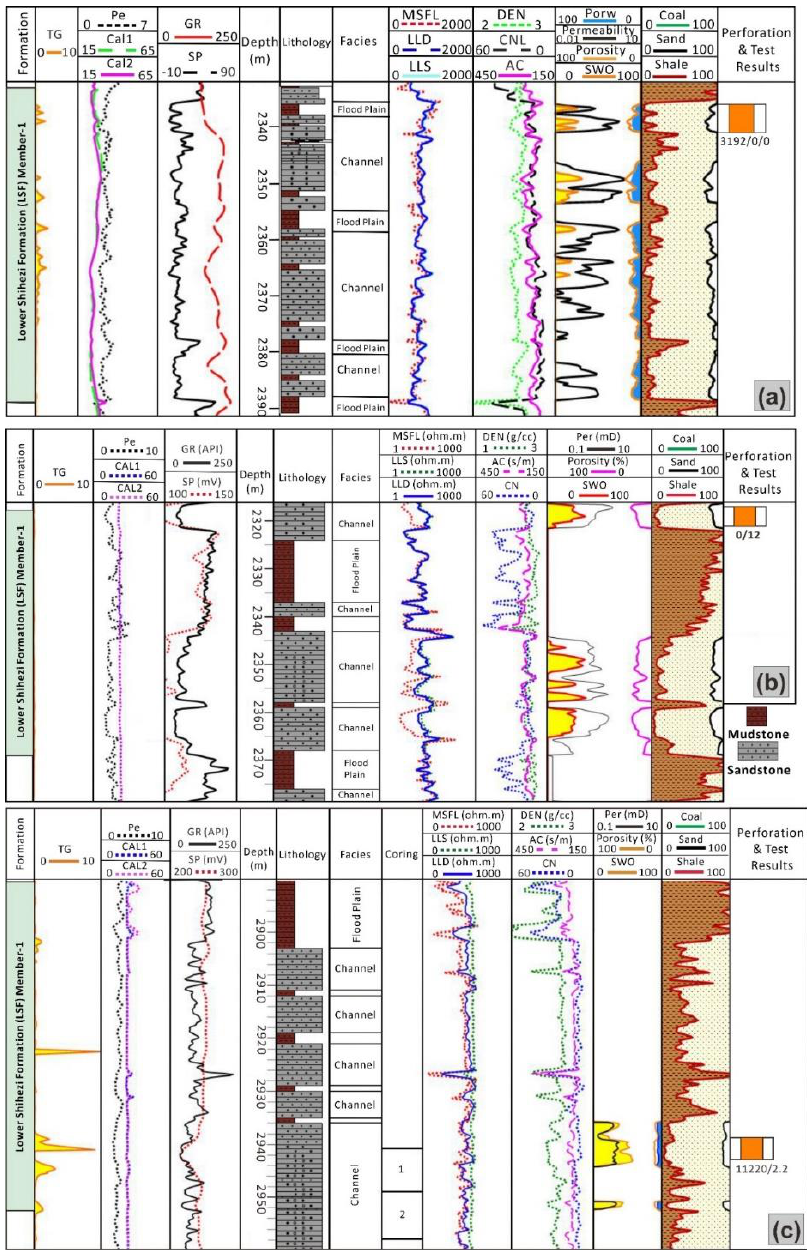
Figure 13. Well log interpretation of wells ( a ) J34, ( b ) J52, ( c ) J72.